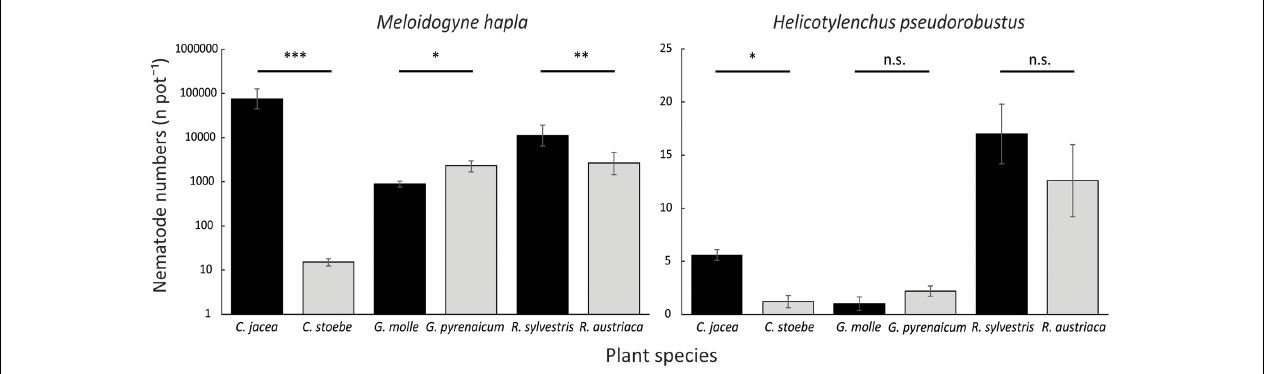
FIGURE 2 | Mean total numbers (N pot − 1 ) of root-feeding nematodes M. hapla (left; logarithmic scale) and H. pseudorobustus (right; linear scale) on range-expanding plant species C. stoebe , G. pyrenaicum, and R. austriaca (gray), and congeneric natives C. jacea , G. molle, and R. sylvestris (black). Vertical bars show means ± standard errors. Asterisks indicate levels of significance ( ∗ p < 0.05, ∗∗ p < 0.01, ∗∗∗ p < 0.001, n.s., not significant) of pairwise post hoc Wald tests within plant pairs.